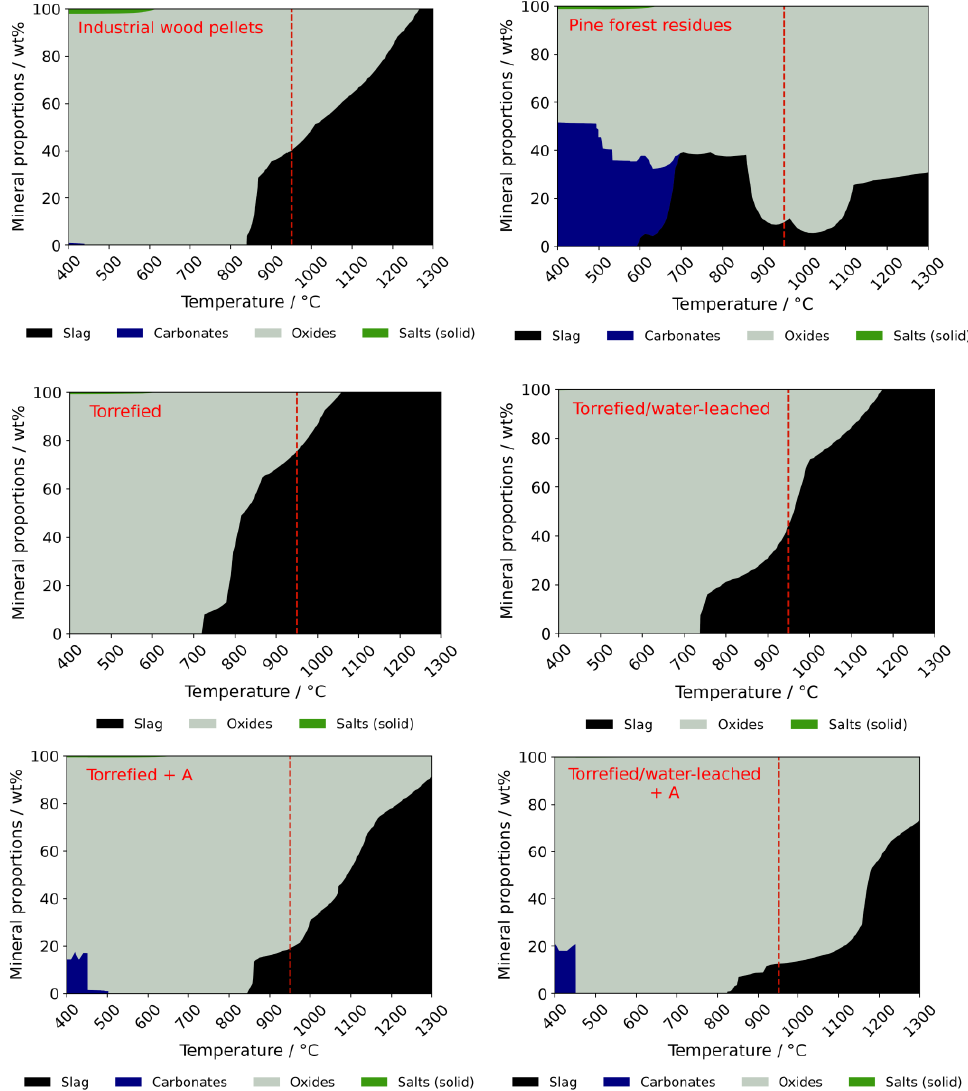
Figure 15. Calculated mineral proportions for industrial wood pellets, pine forest residues, and pre-treated or CaCO 3 -blended wheat straw ash. The dashed line denotes the fixed gasification temperature (950 °C).